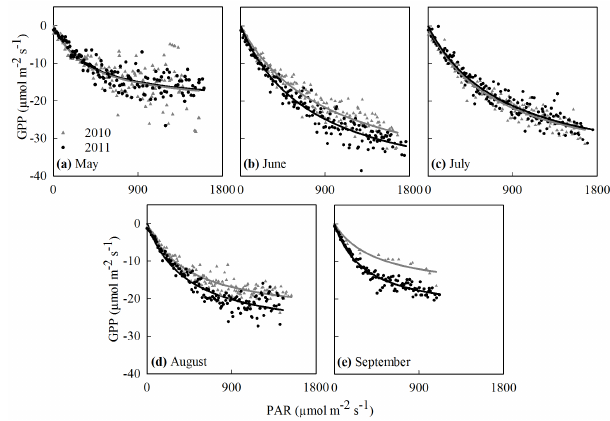
to incident photosynthetically active radiation (PAR). Mea- sured monthly (mid-May–September) GPP (µmolm − 2 s − 1 ) averaged with binned (steps of 10µmolm − 2 s − 1 ) PAR (µmolm − 2 s − 1 ) for 2010 (closed grey triangles) and 2011 (closed black circles). Data are fitted with nonlinear regression (GPP = (GP max × PAR × α /(GP max + PAR × α)) between GPP and PAR (fit results in Table 1). Only measured data were used in the